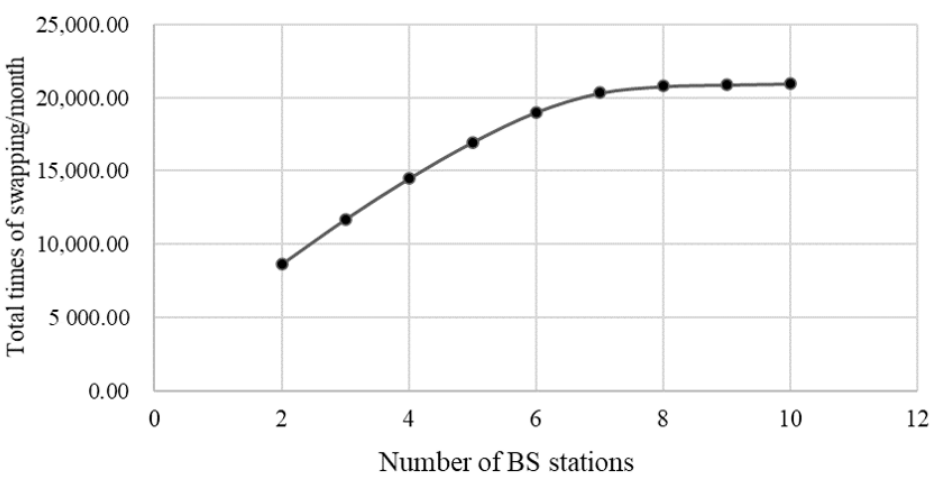
Figure 16. No. of attracted